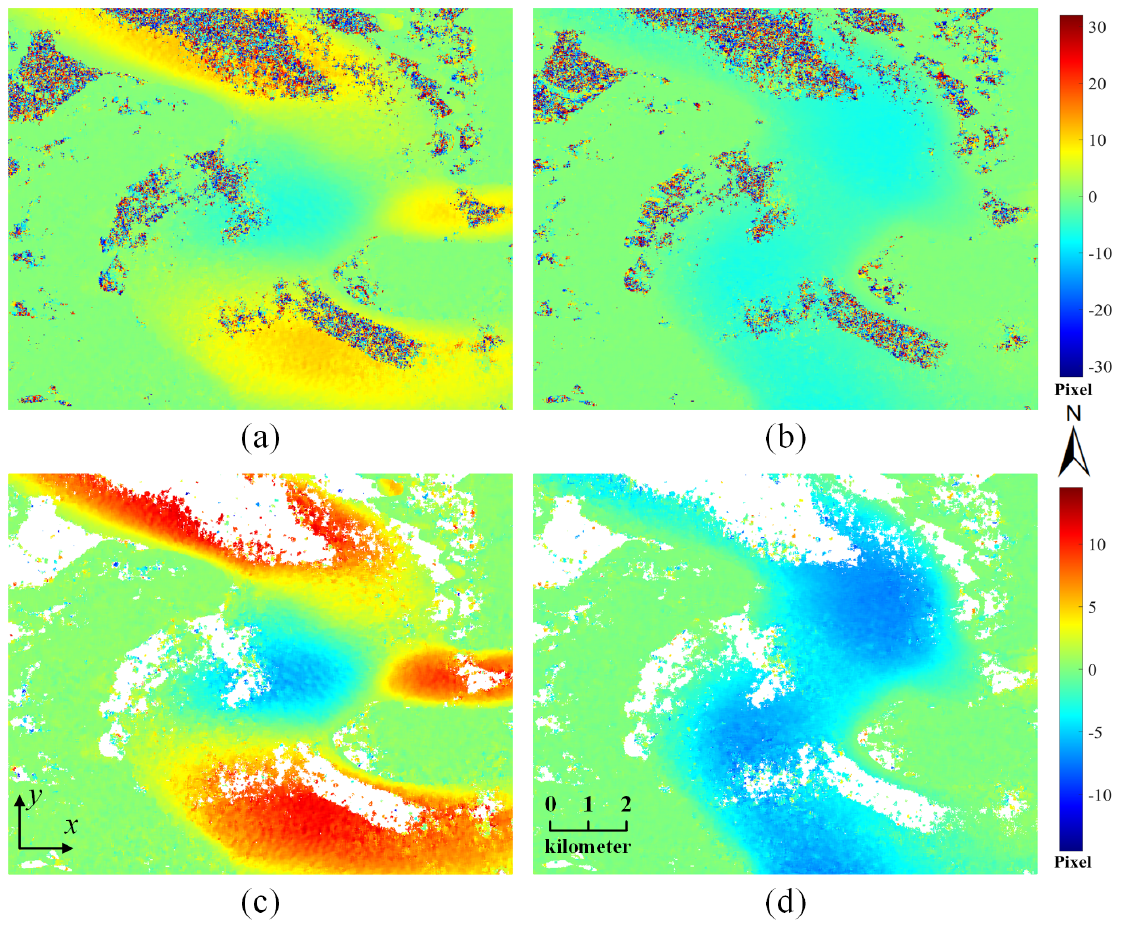
Figure 5. ( a ) x -direction and ( b ) y -direction displacement maps of the Taku Glacier derived from the LUGC method; ( c ) x -direction and ( d ) y -direction displacement maps after outlier removal. In Figure 6a, the magnitudes of surface motions over the glacierized regions were generated using the displacement maps and a manual labeled mask. It can be found that the maximal motion can reach approximately 25 m on the ground during the revisit period of 11 days. As shown in Figure 6b, motion fields of two representative areas were selected and illustrated with the direction of arrows indicating the direction of movement and the color indicating the magnitude of movement. In the first area, the motion field is locally anisotropic, and the turning of the flow direction can be observed. In the second area within the terminus region, the glacier moves in a coherent trend with the magnitude increasing from the boundary part to the central